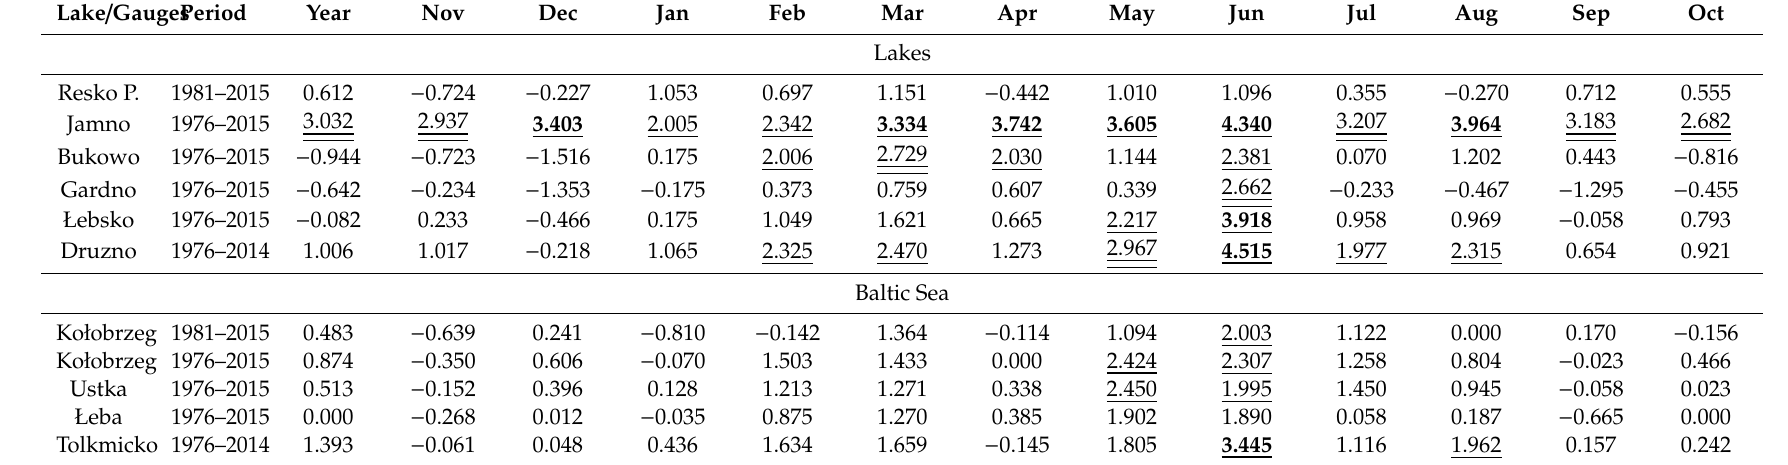
Table 4. Results of Mann–Kendall test for maximum annual and monthly water